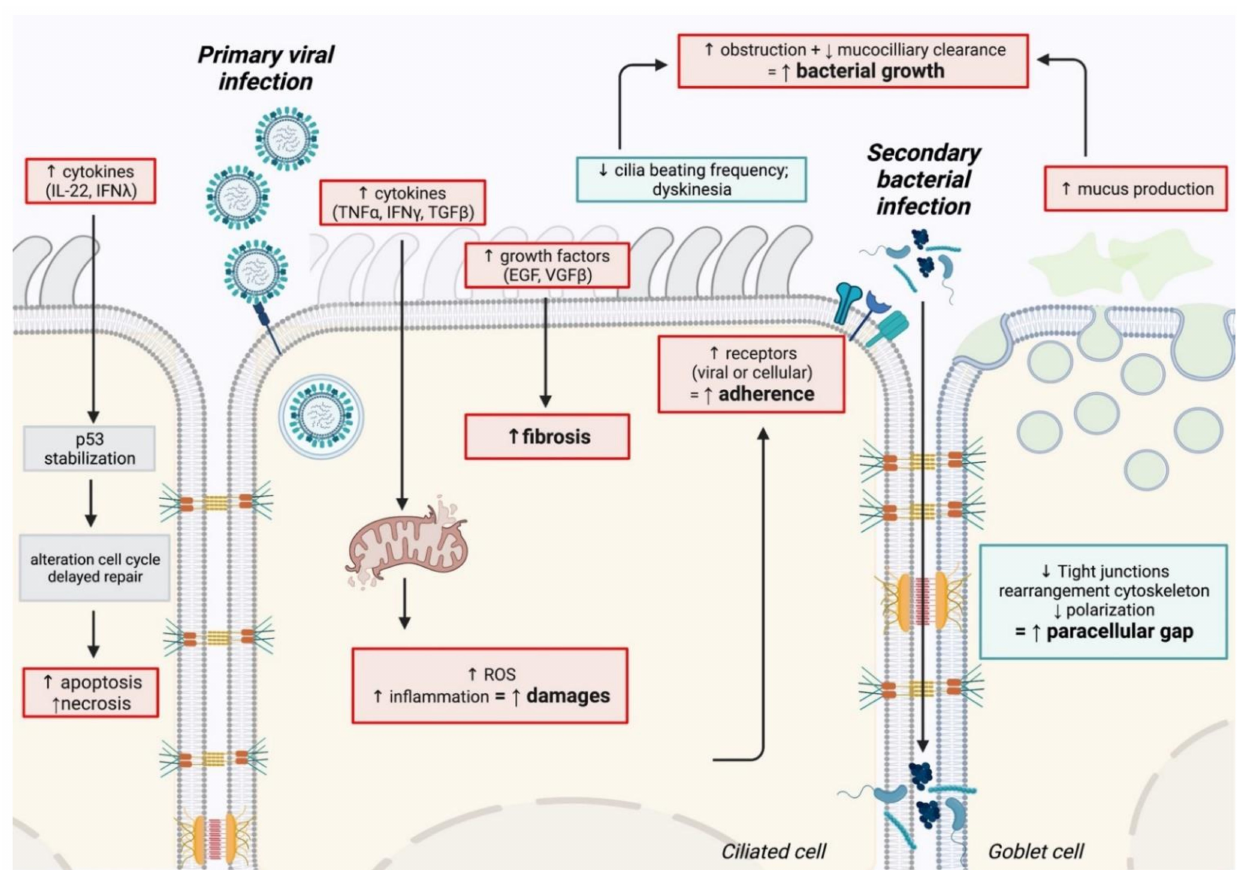
Figure 1. Schematic representation of the physiological mechanisms associated with bacterial superinfections. The impact of the primary viral infection on the integrity and functionality of the epithelium (epithelial damage, repair delay) contributes to creating a favorable environment for the establishment of a secondary bacterial infection. Created with